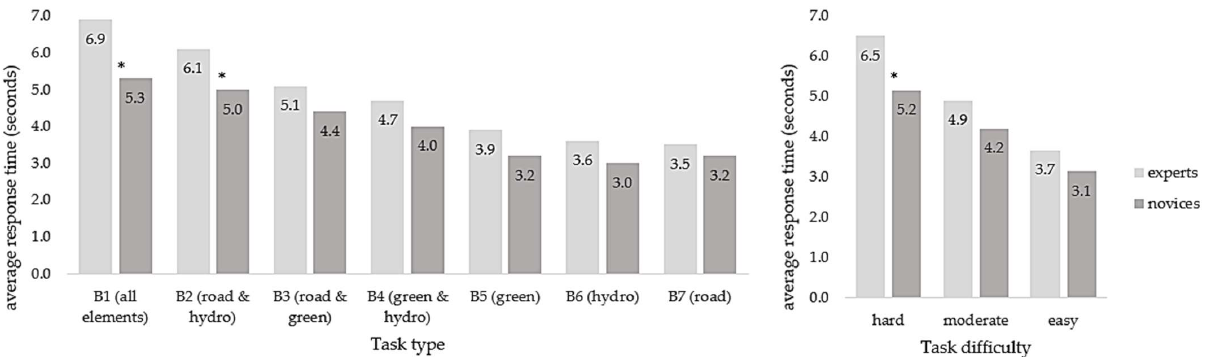
Figure 9. Average response times of experts and novices: ( left ): per task type; ( right ): aggregated based on task difficulty. Experts take consistently longer to complete the tasks, but the effect is statistically significant only in some tasks. * p < 0.05,.